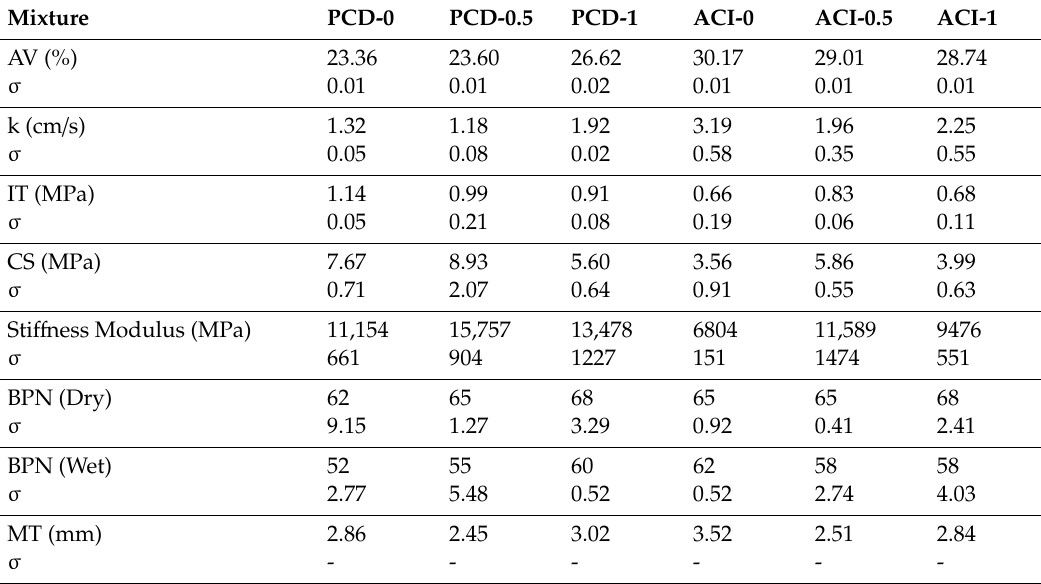
Table 3. Mixtures general results for every test